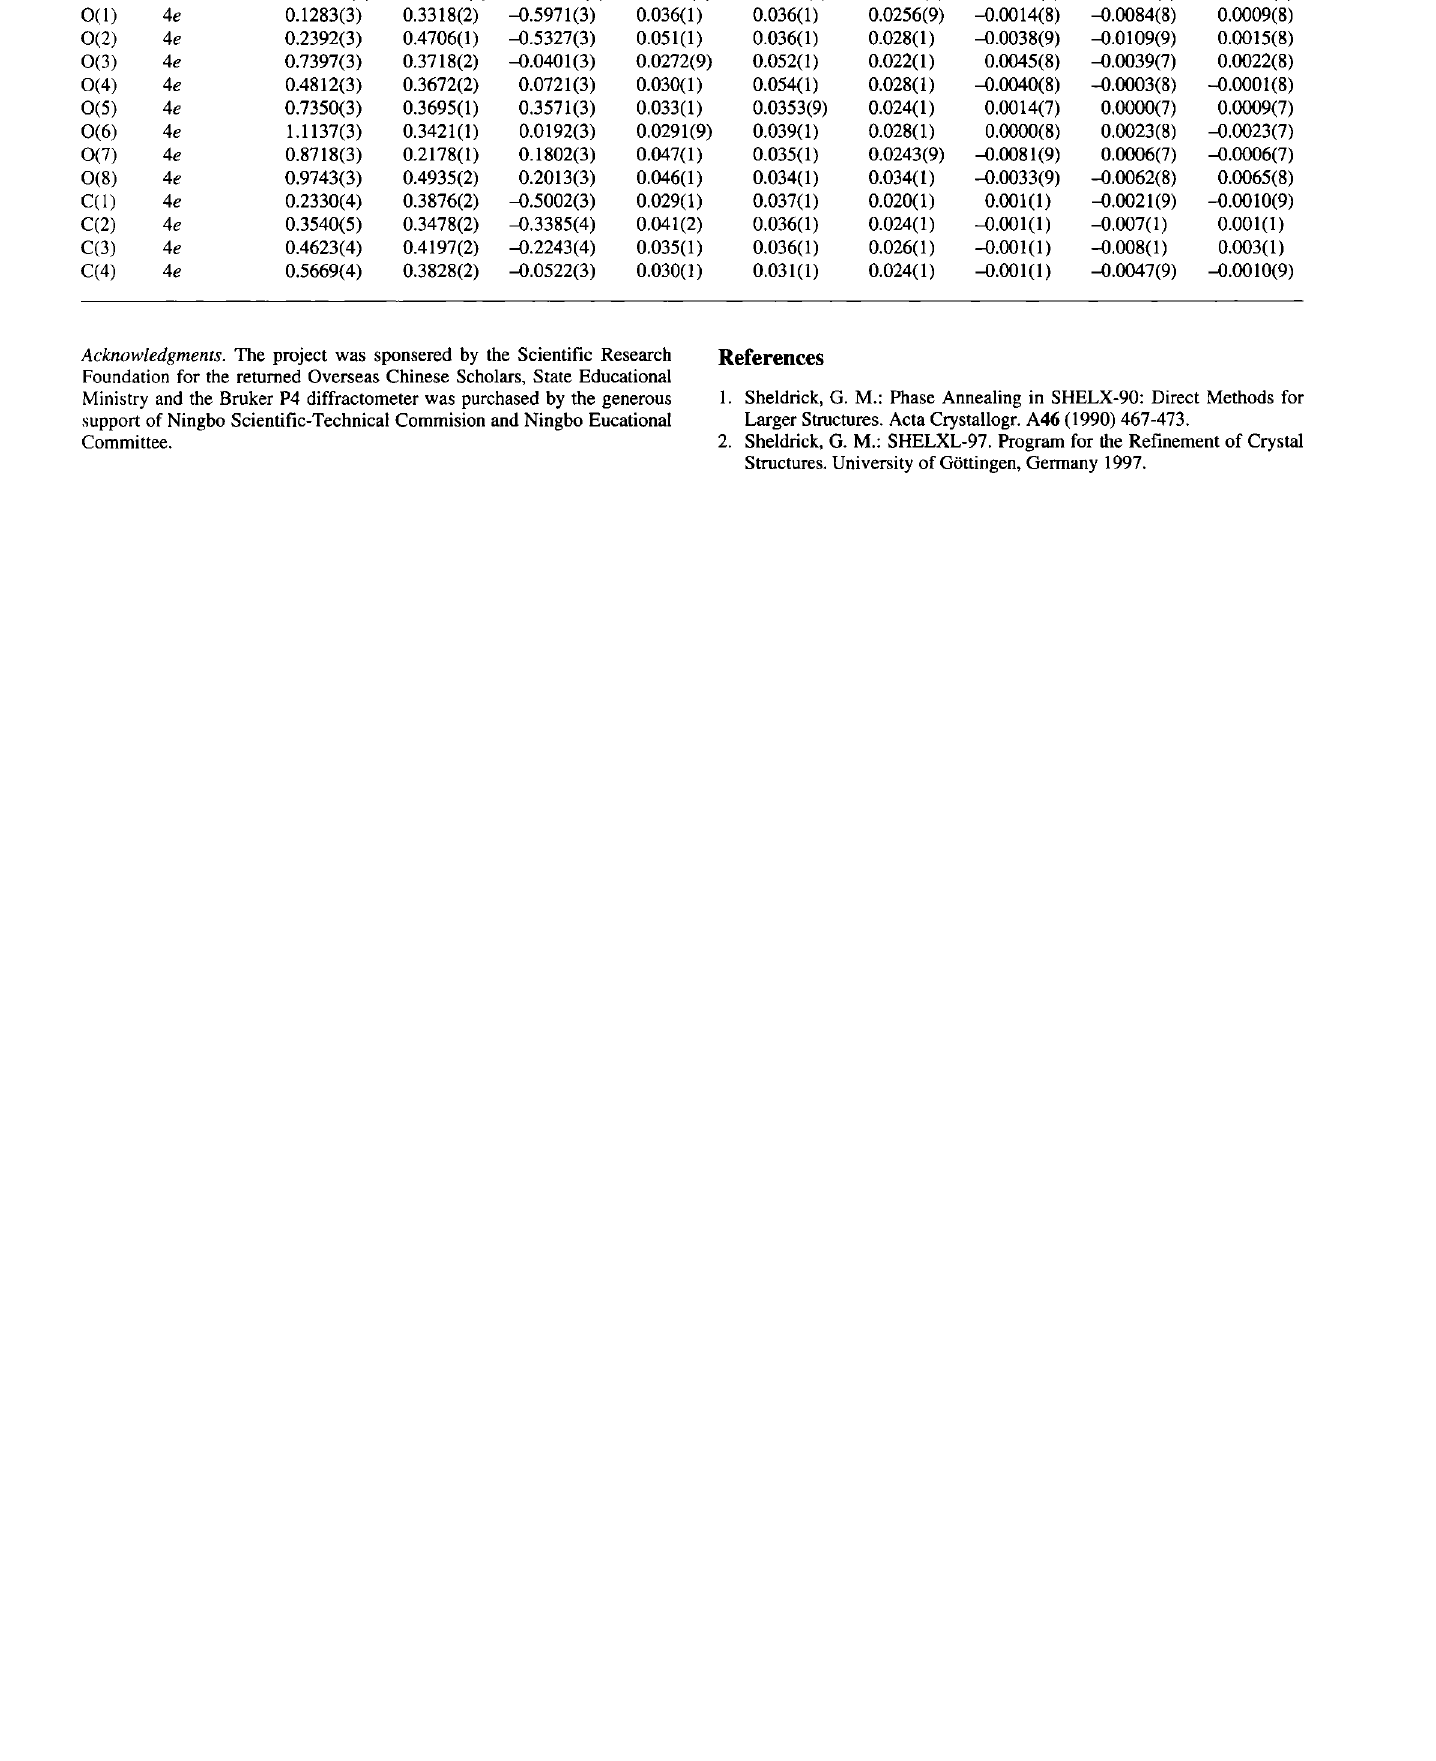
Table 3. Atomic coordinates and displacement parameters (in Ä 2